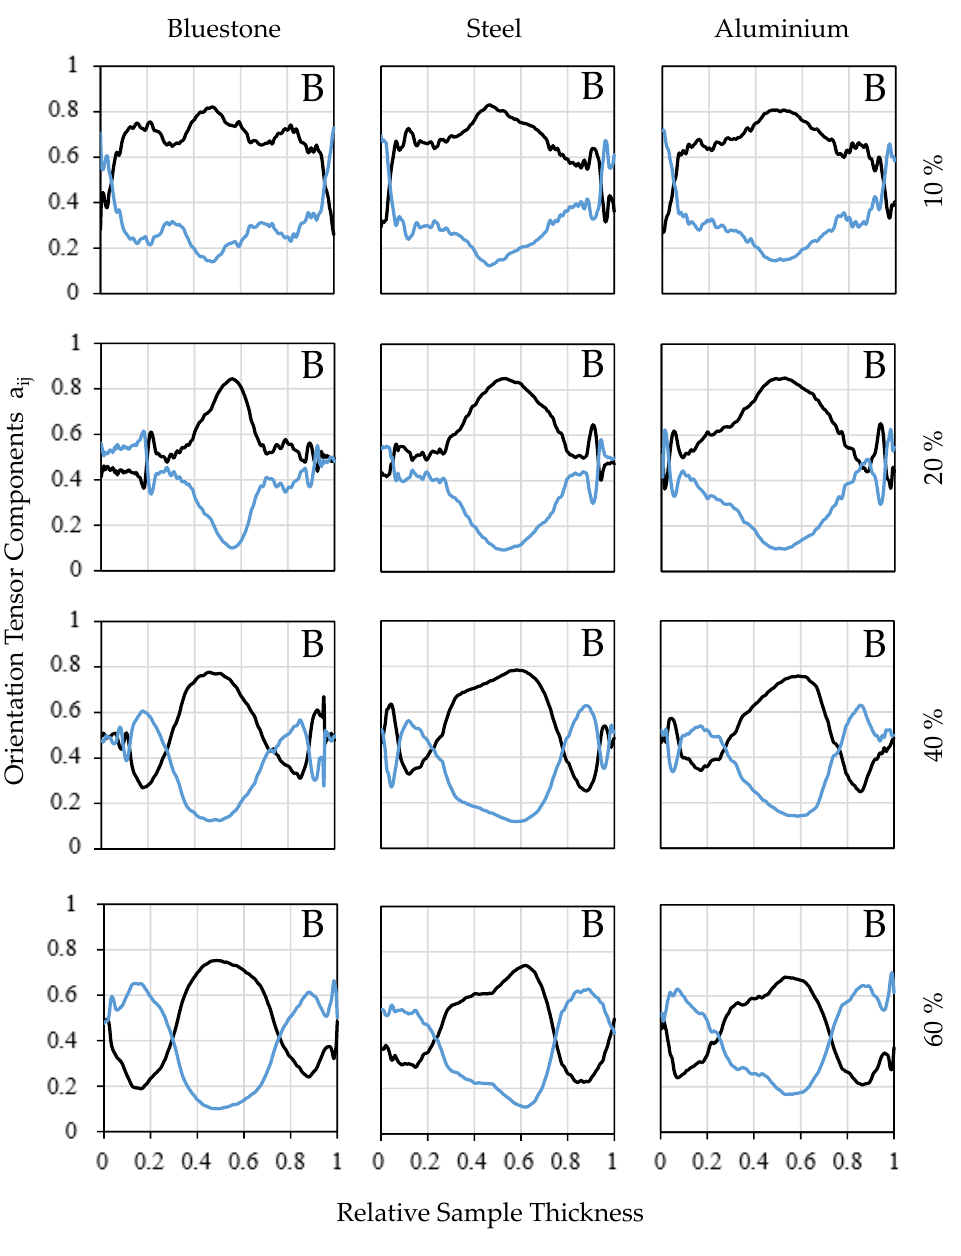
Figure 23. Orientation tensor components ( a 11 , a 22 ; without a 33 for better overview) and relative sample thickness for nominal fiber contents of 10 wt.%, 20 wt.%, 40 wt.%, and 60 wt.%. Specimens were created with Bluestone, steel, and aluminum tools.